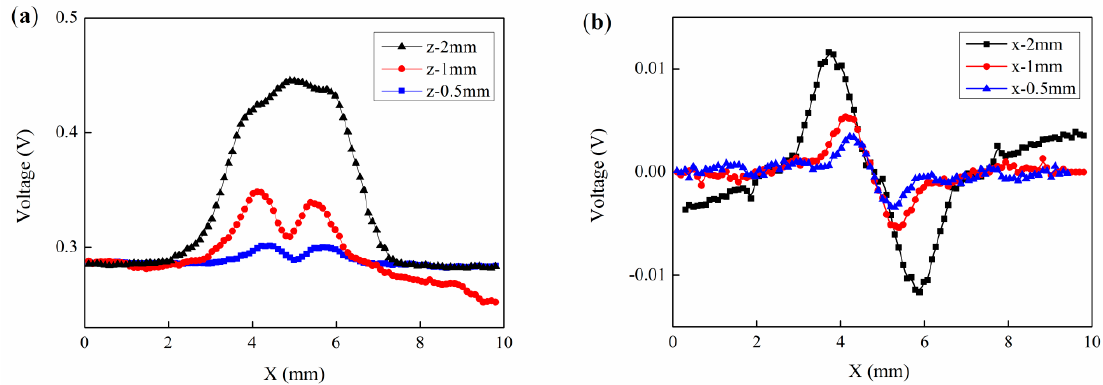
Figure 7. Measured force acting on the PM for through-hole defects of various diameters. ( a ) z-component and ( b ) x-component.